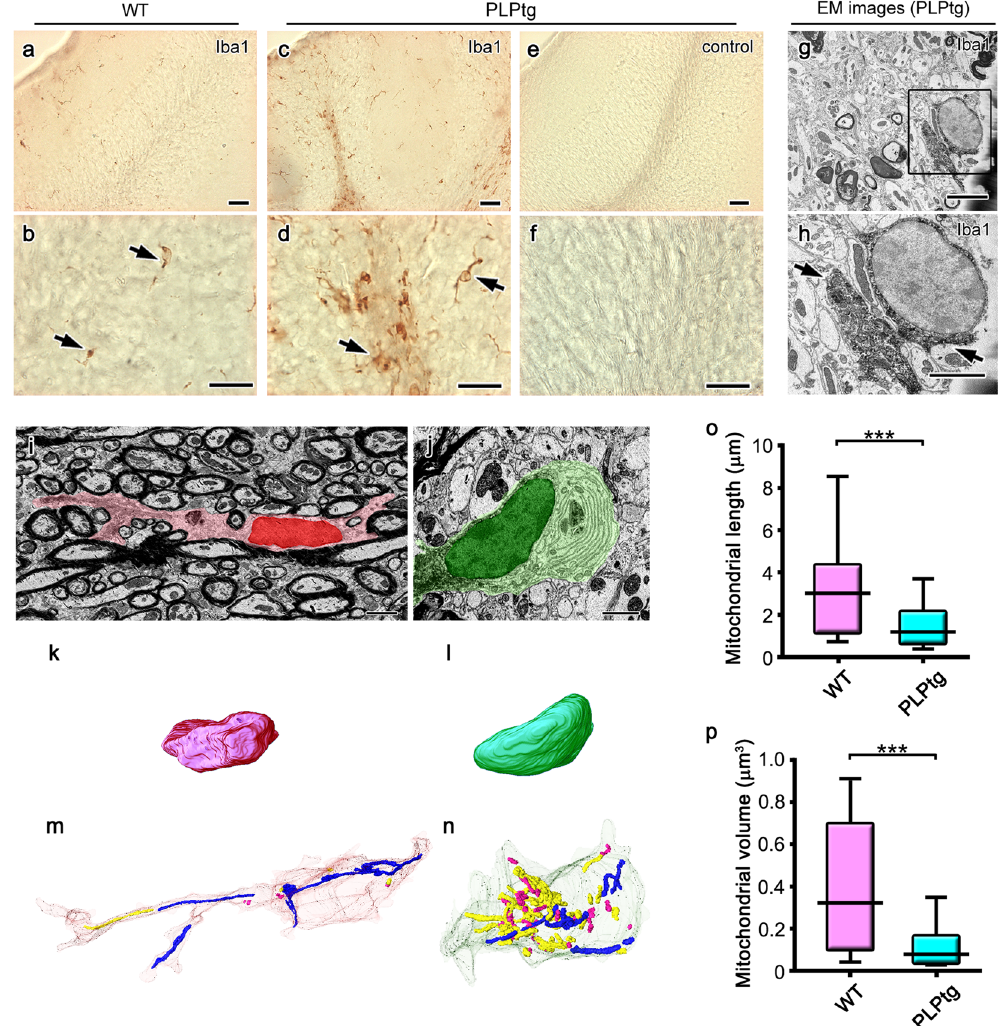
Figure 2. Shorter and smaller mitochondria predominate in amoeboidal microglia in demyelinated cerebellar white matter obtained from mice overexpressing proteolipid protein (PLP). Light micrographs of Iba1 immunostaining in the cerebella of 5-month-old wild-type (WT, a,b ) and PLP-overexpressing (PLPtg, c–f ) mice. Immunocontrol sections are also shown ( e,f ). In immunoelectron micrographs (EM) with DAB deposits for Iba1 ( g,h , arrows), the area indicated with a rectangle ( g ) is magnified ( h ). Single electron micrographs ( i,j ) and 3D reconstructions of nuclei ( k,l ) and mitochondria ( m,n ) of Iba1-positive cells in the cerebellar white matter of WT ( i,k,m ) and PLPtg ( j,l,n ) mice are shown and mitochondrial length ( o ) and volume ( p ) were statistically compared. Long and short mitochondria are colored in blue and magenta, respectively ( m , n ). *** p < 0.001 in the U -test. N = 68 or 506 for mitochondria in WT or PLPtg microglia. Bars: 50 μ m ( a,c,e ), 20 μ m ( b,d,f ), 2.5 μ m ( g–j